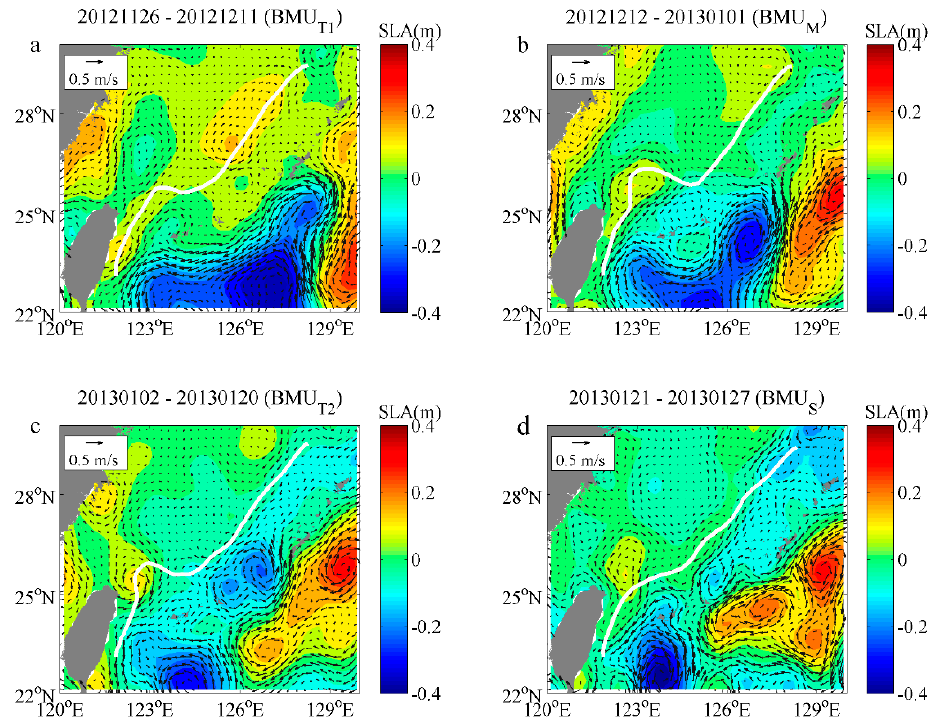
Figure 15. Same as Figure 13, but for the SLA and the geostrophic velocity